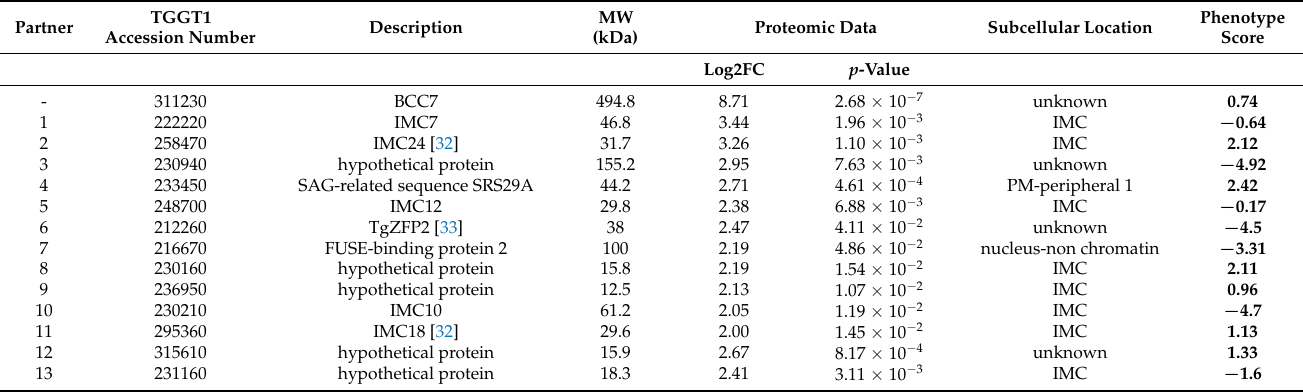
Table 1. List of putative BCC7-binding proteins identified by co-IP coupled to MS-based proteomics. Identity of proteins was assigned by ToxoDB [19] unless specified (*) and their subcellular location was determined by Hyper Lopit approach [20]. Parasite fitness during the lytic cycle was evaluated from the genome-wide CRISPR screen